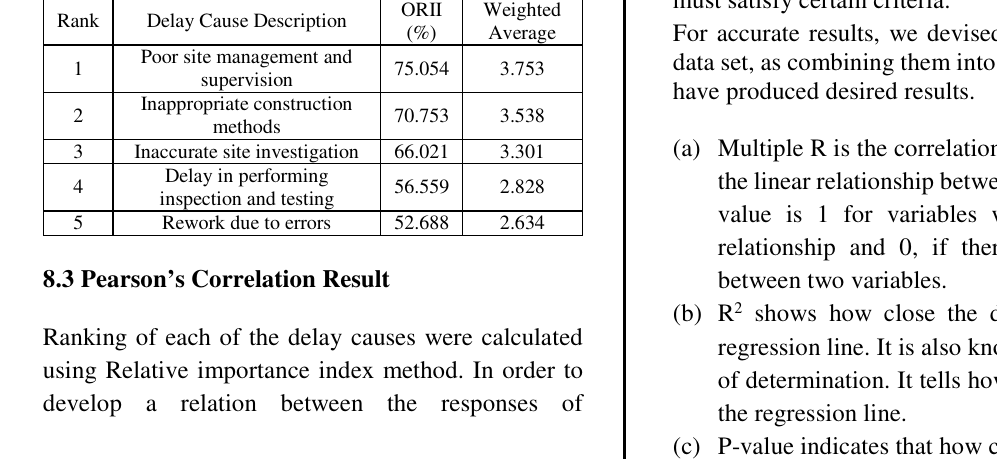
Table 8: Ranking of Delay Causes Related to On-Site